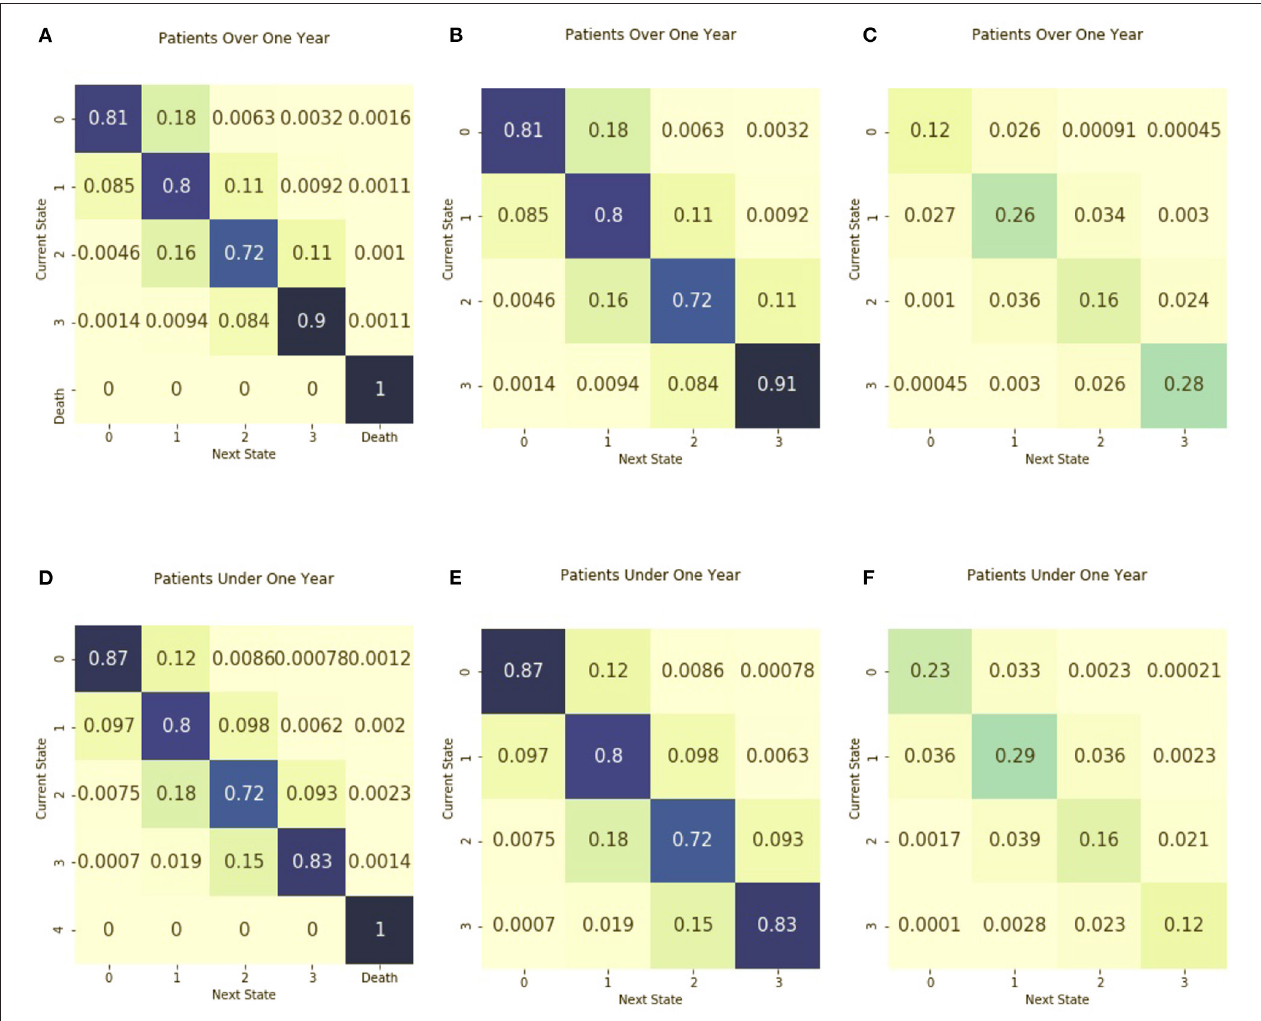
FIGURE 3 | Transition matrices stratified by age group. Separate transition matrices were created for (A) patients older than 1 year of age and including death as an absorbing state (B) patients older than 1 year of age and including only transient illness states, and (C) the entropy matrix for patients older than 1 year of age. The transition matrices are shown for (D) patients from birth to age one, including death as an absorbing state (E) patients from birth to age one with only transient illness states, and (F) the entropy matrix for patients from birth to age